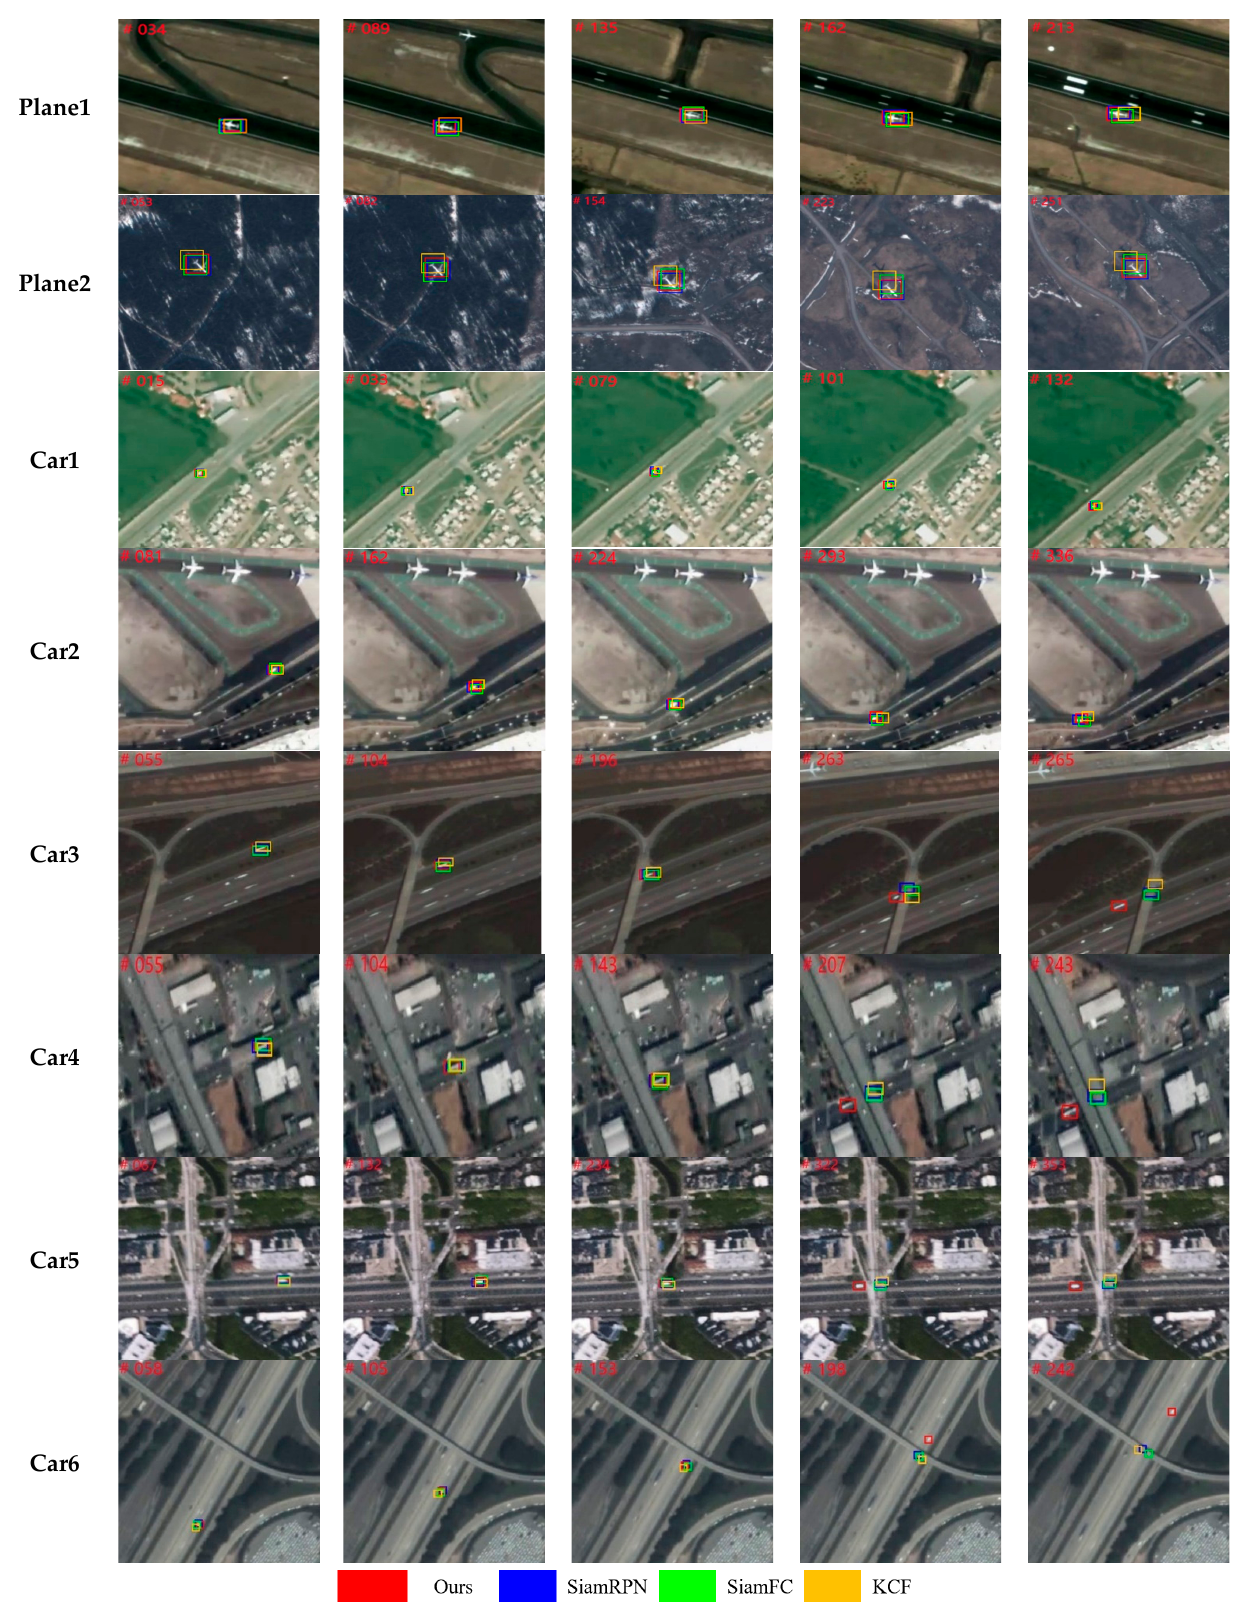
Figure 14. Screenshots of some tracking results without occlusion. At each frame, the bounding boxes with different colors are the tracking results of the different trackers and the red number in the top-left corner is the frame number of the current frame in the satellite videos.